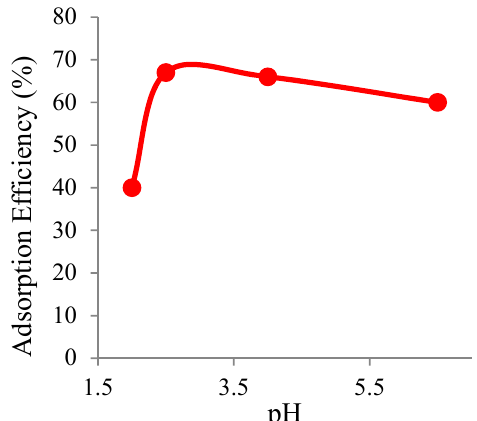
Fig. 7: Effect of adsorbent dosage on the adsorption efficiency of cadmium.